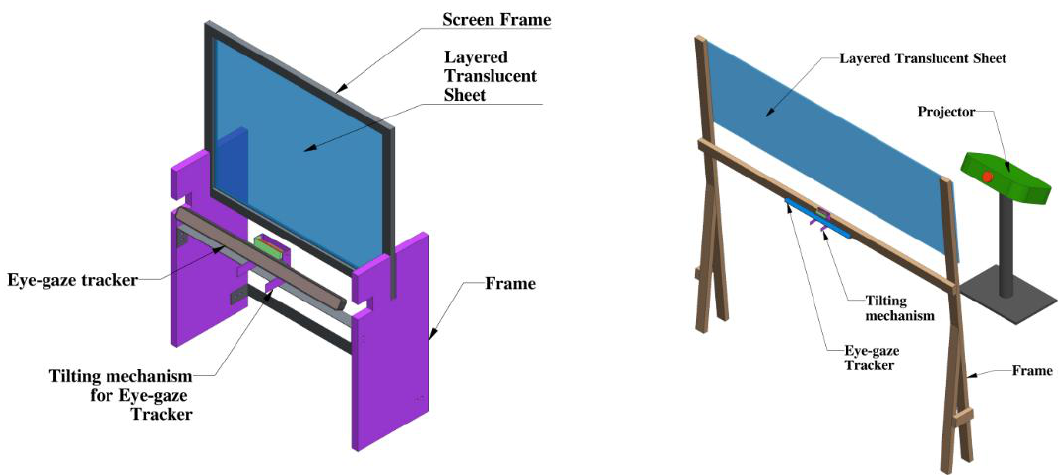
Figure 6. The projected screen set up (left one for automotive, right one for aviation).